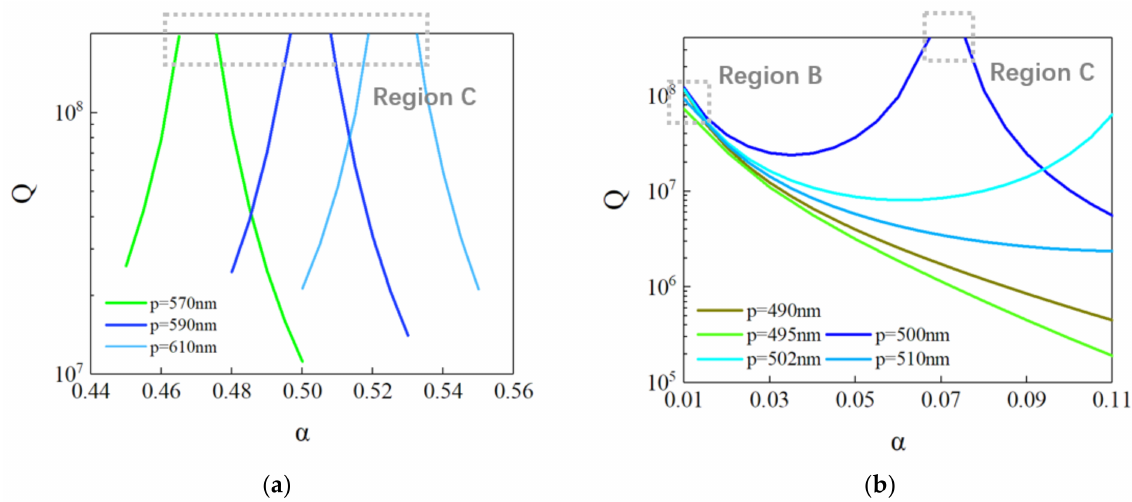
Figure 5. The variation in Q factor of TM C modes with the asymmetry parameter α under different periods. ( a ) When the period is near 600 nm, the peak wavelength is around 960 nm, and BIC is around α = 0.5. ( b ) When the period is near 500 nm, the peak wavelength is around 820 nm, and BIC is around α =